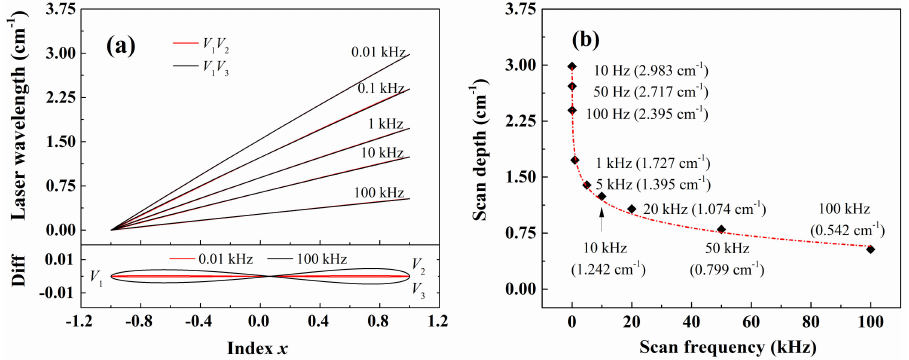
Figure 5. ( a ) The relationship between laser wavelength and variable x in both rising ( V 1 V 3 ) and falling ( V 1 V 2 ) edges for di ff erent modulation frequencies. ( b ) The relationship between the tuning coe ffi cient and modulation